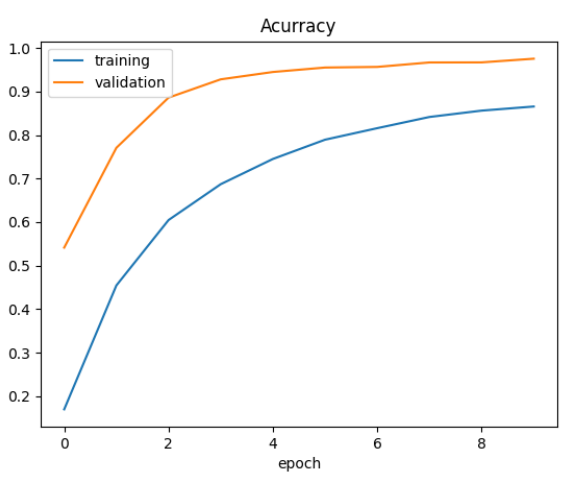
Fig. 14. Plot of training set accuracy and validation set accuracy